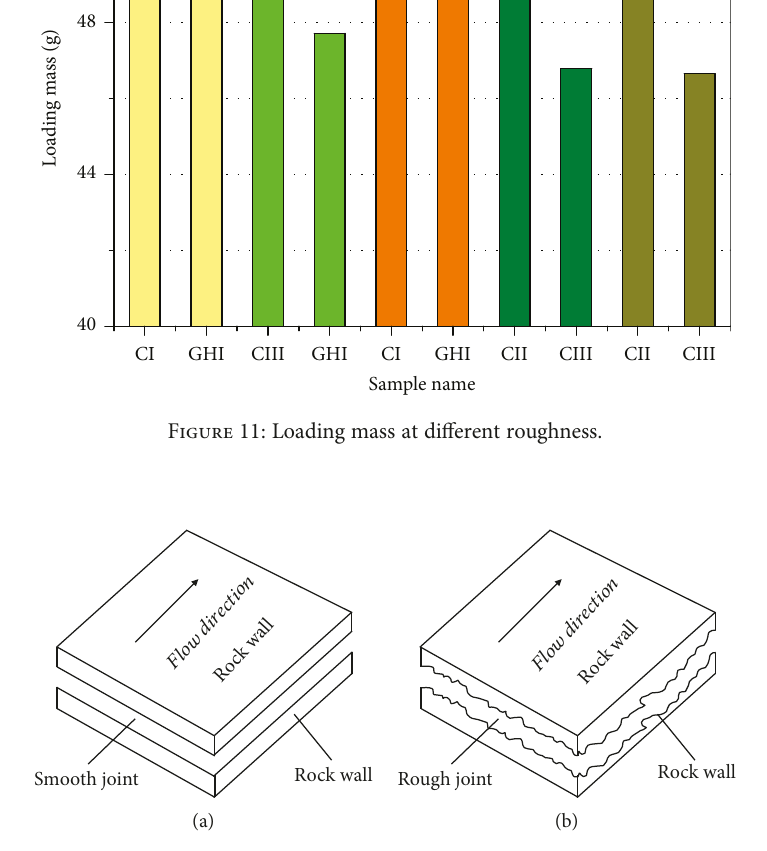
Figure 12: Model of fracture: (a) parallel plate model and (b) rough fracture model.